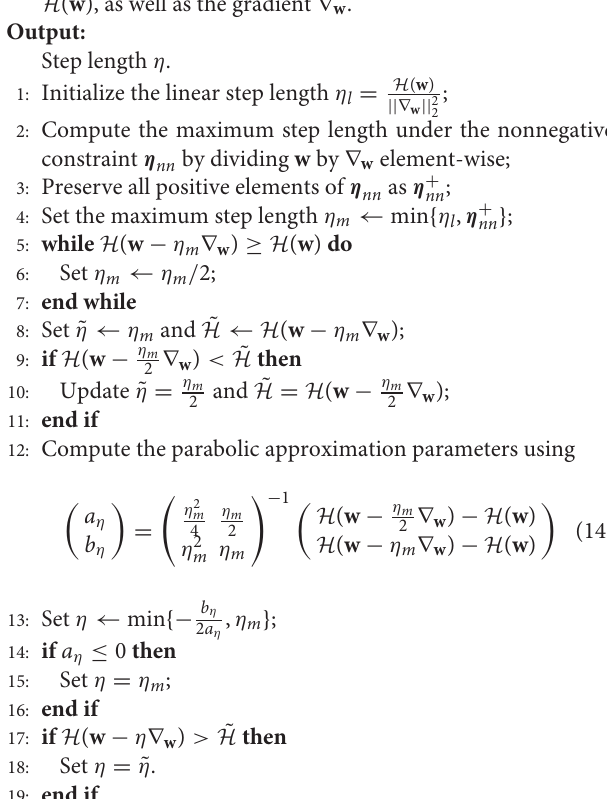
Algorithm 2 Algorithm to Solve COL